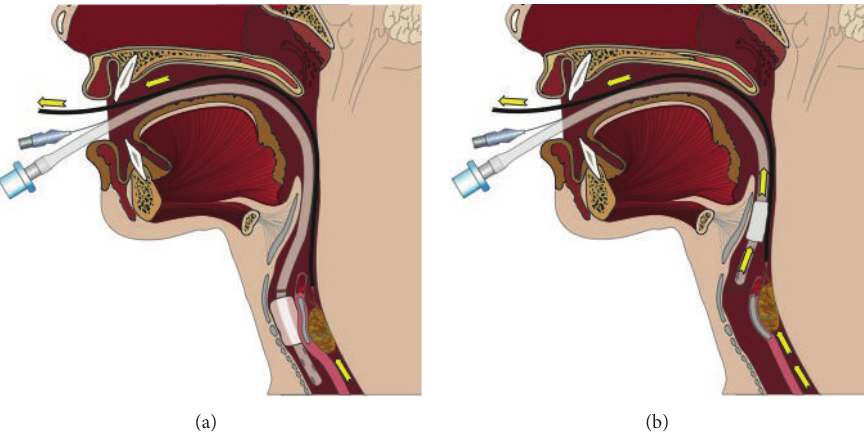
Figure 3: Mass effect of trichobezoar being pulled up (a) and pushing against the posterior tracheal wall causing extubation